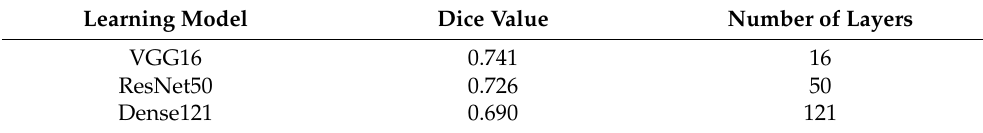
Table 1. VGG16 shows better segmentation performance compared to ResNet50 and Dense121.